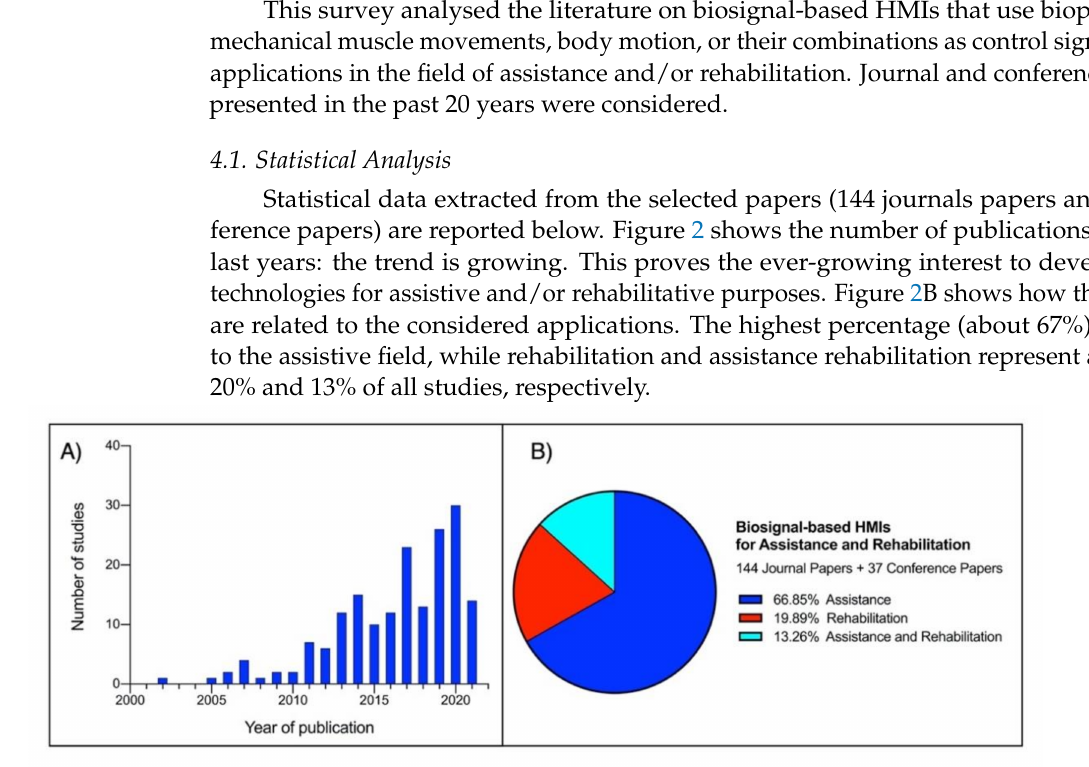
Figure 2. ( A ) Histogram illustrating the trend in the last two decades in the number of studies selected for the current survey. ( B ) Pie chart presenting the percentage distribution of the selected studies, according to the field of